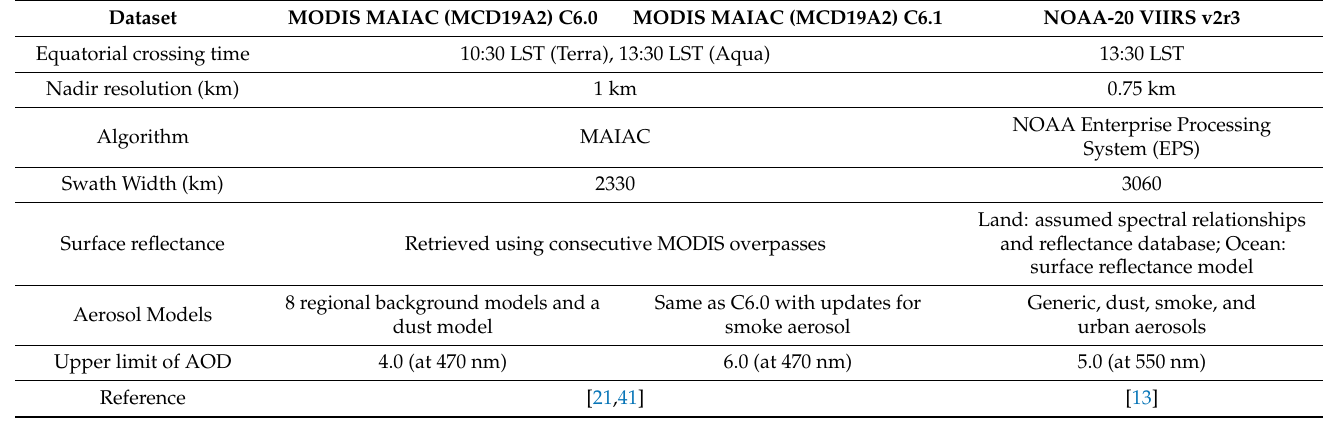
Table 1. Summary of the AOD products evaluated in this